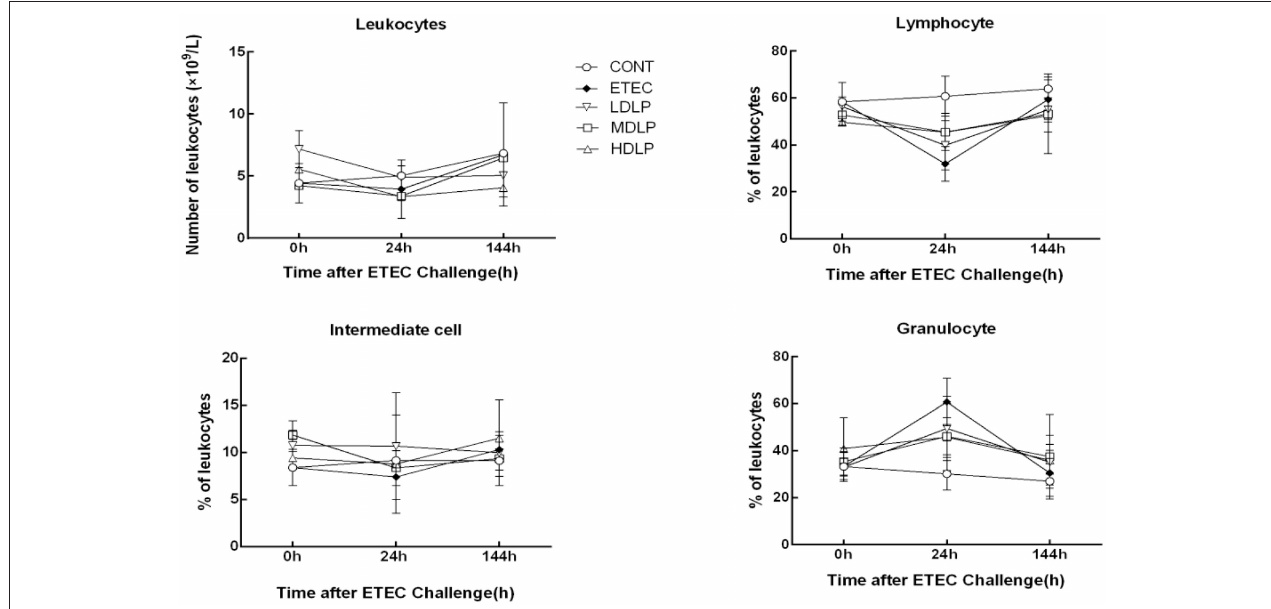
FIGURE 2 | Dose effect of Lactobacillus plantarum on blood leukocyte count and population distribution of mice during pre- and post-challenge periods. CONT, control group, treatment with PBS at all period; ETEC, negative group, oral challenge with ETEC on day 15; LDLP, low dose (5.0 × 10 8 cfu mL − 1 ) group; MDLP, intermediate dose (5.0 × 10 9 cfu mL − 1 ) group; HDLP, high dose (5.0 × 10 10 cfu mL − 1 ) group; LDLP, MDLP, and HDLP groups were infected with ETEC at day 15. At 24h after ETEC challenge, lymphocyte concentrations decreased ( P < 0.05) and granulocyte concentrations increased ( P < 0.05) in ETEC group and Lactobacillus -supplemented groups as compared to CONT group.